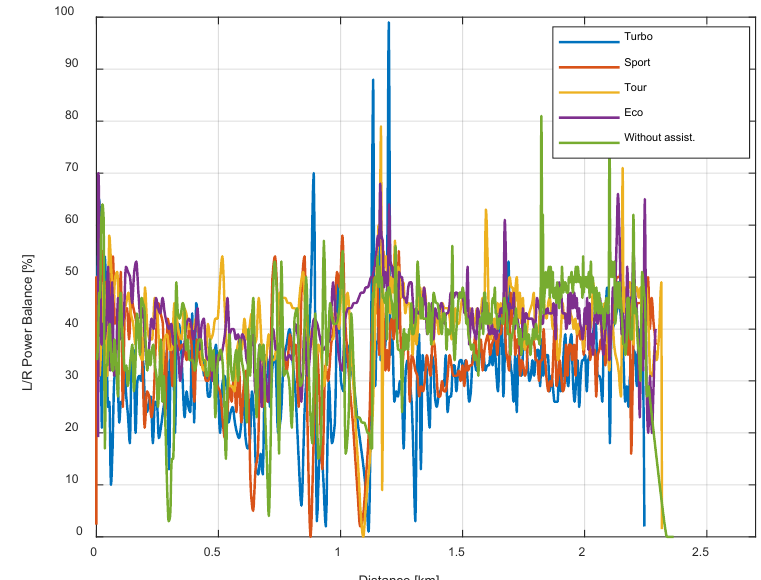
Figure 11. Left/right power balance.